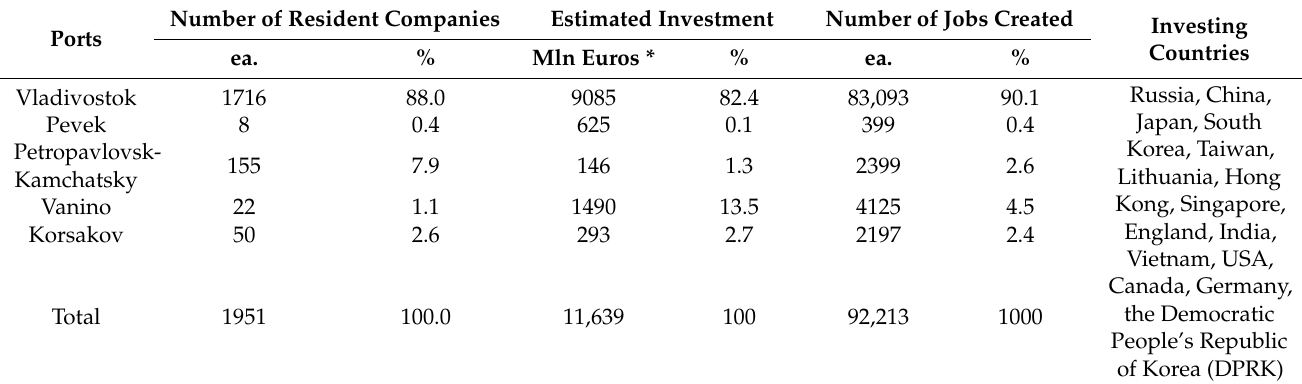
Table 1. Basic data of the free port of Vladivostok (as of 1 July